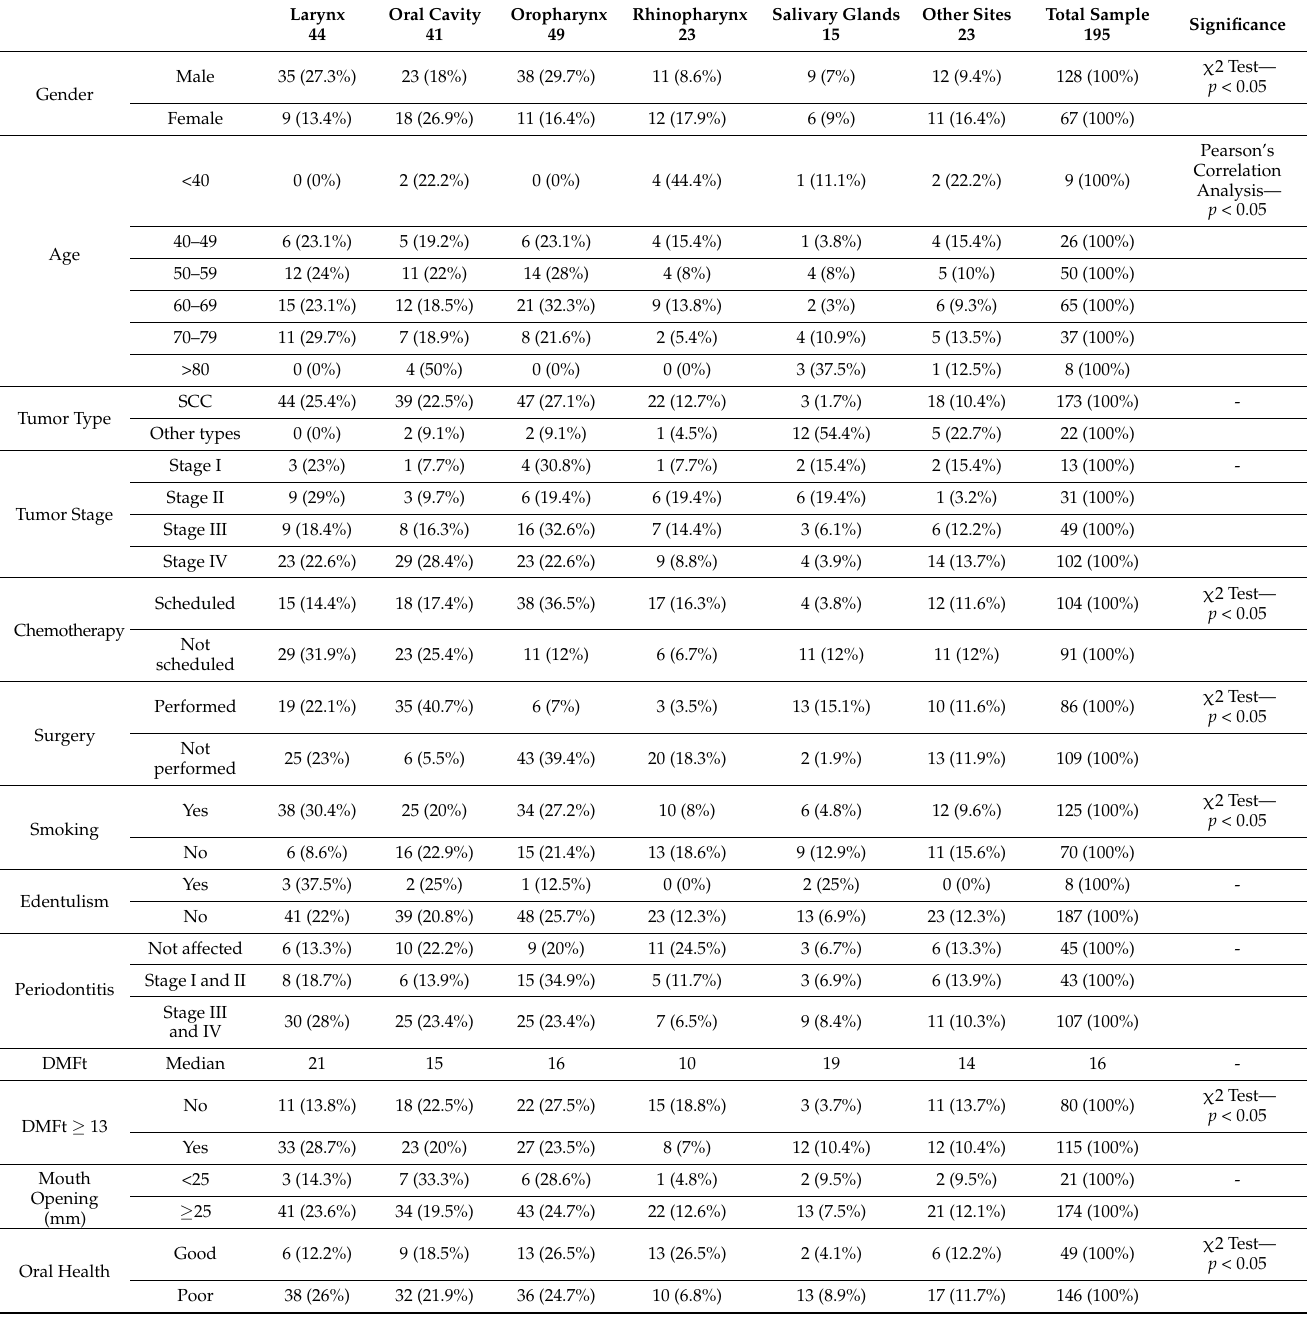
Table 3. General and oral health characteristics of the studied population, according to the localization of the